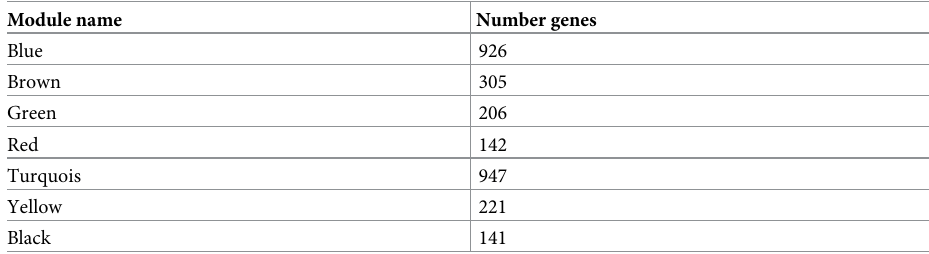
Table 3. Modules of hormonal treatment